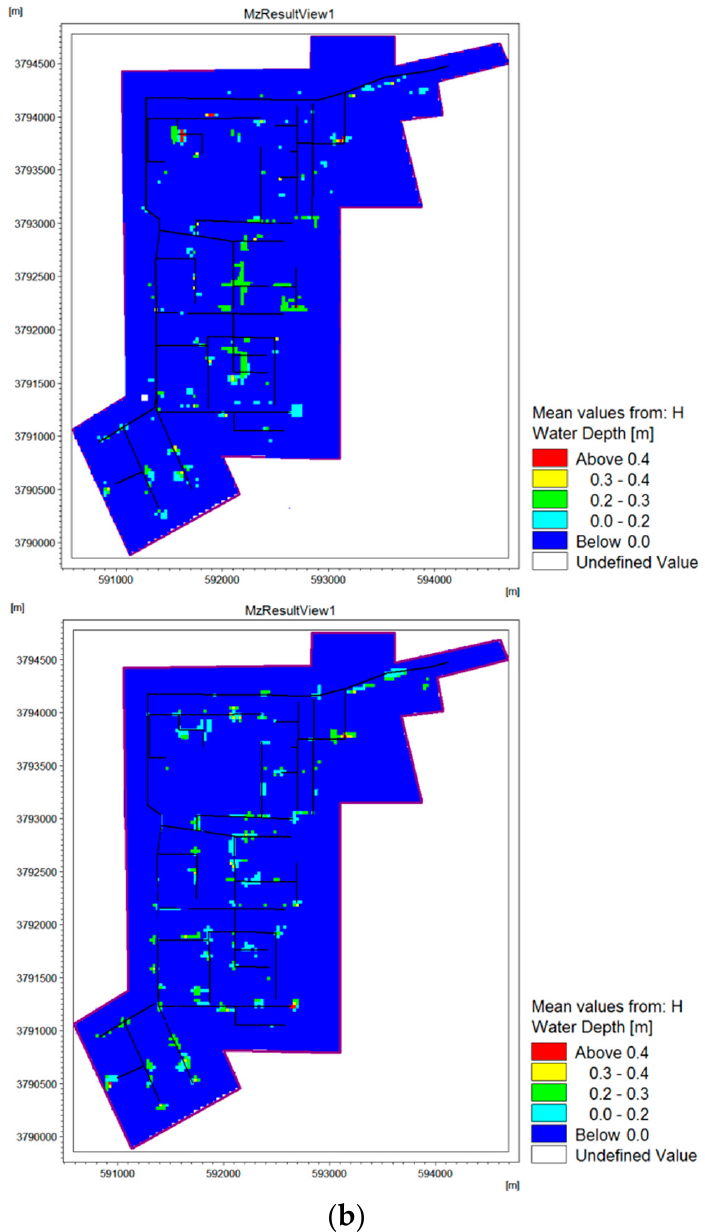
Figure 6. Distribution of rainstorm waterlogging at different submerged periods. ( a ) Distribution of rainstorm waterlogging at different submerged periods during the 5-year recurrence interval with no rain garden and rain garden regulation; ( b ) Distribution of rainstorm waterlogging at different submerged periods during the 20-year recurrence interval with no rain garden and rain garden regulation.